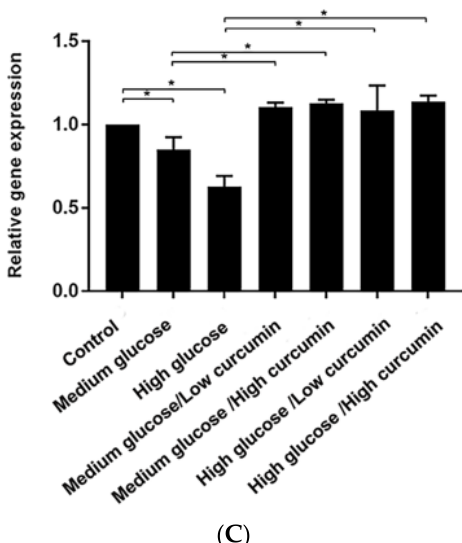
Figure 3. Effects of curcumin on osteogenic differentiation of MC3T3 cells in glucose conditions. Expressions of ( A ) Runx2, ( B ) Opn, and ( C ) Col-1 were measured by reverse transcription quantitative polymerase chain reaction (RT-qPCR; n = 3). The results are shown as a relative expression level of the target gene using glyceraldehyde-3-phosphate-dehydrogenase (GAPDH) as the inner reference gene, and analyzed by 2- ΔΔ Ct. Data are shown as mean ± SD. * p < 0.05.